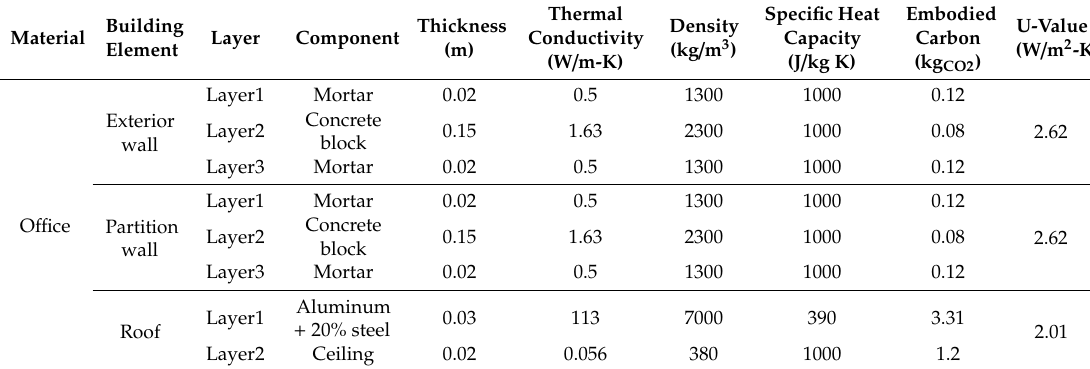
Table 2. Thermal properties of the building